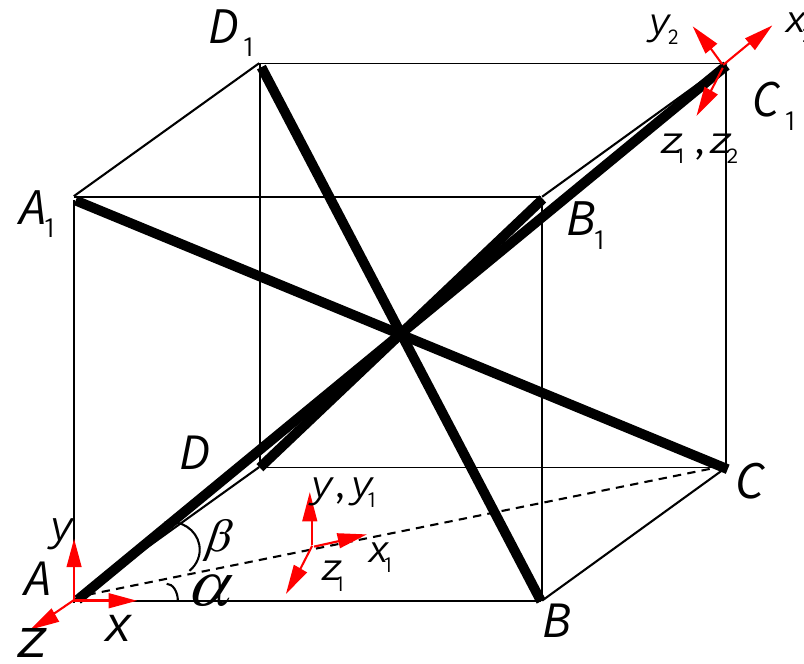
Figure 1. Process of coordinate system conversion.